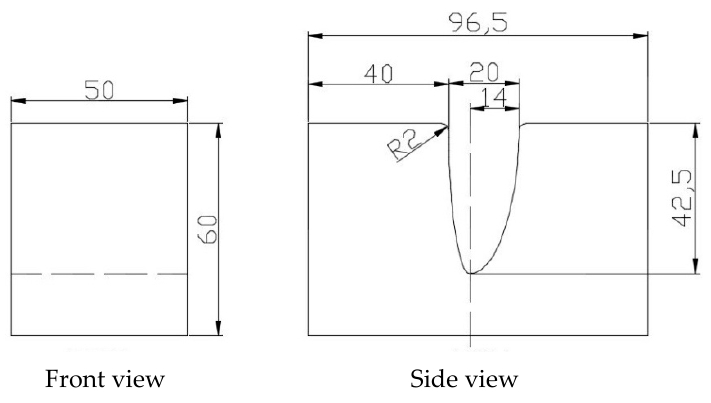
Figure 1. The geometry of forming die.